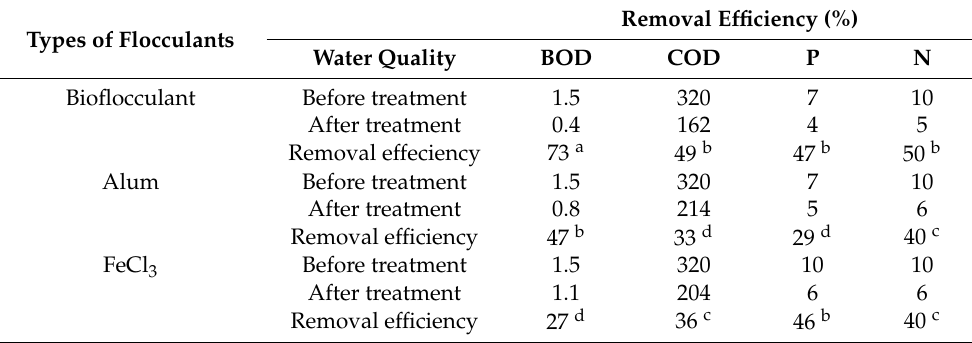
Table 8. The removal efficiency of the bioflocculant on coal mine wastewater. Types of Flocculants